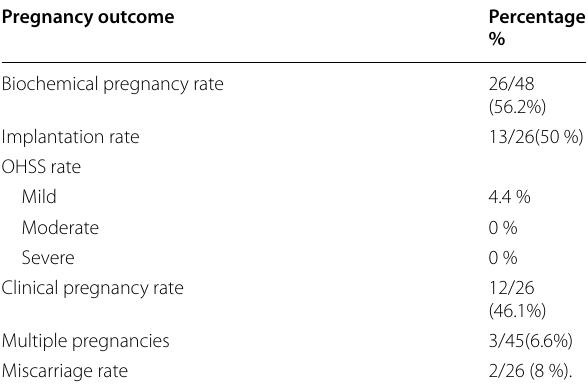
IVF / ICSI in vitro fertilization/intracytoplasmic sperm injection; ET , embryo transfer. The quantitative and qualitative variables are presented as mean (standard deviation) and number (percentage), respectively, recombinant follicle-stimulating hormone; hCG , human chorionic gonadotropin; ET , and embryo transfer. OHSS, ovarian hyperstimulation syndrome the data are presented as mean (